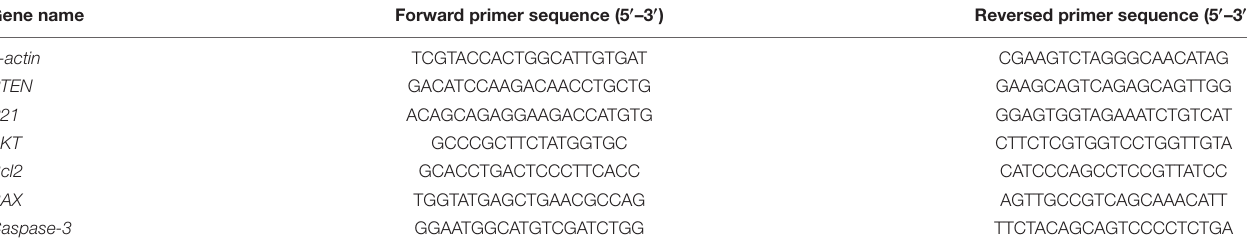
TABLE 1 | The primers used in this